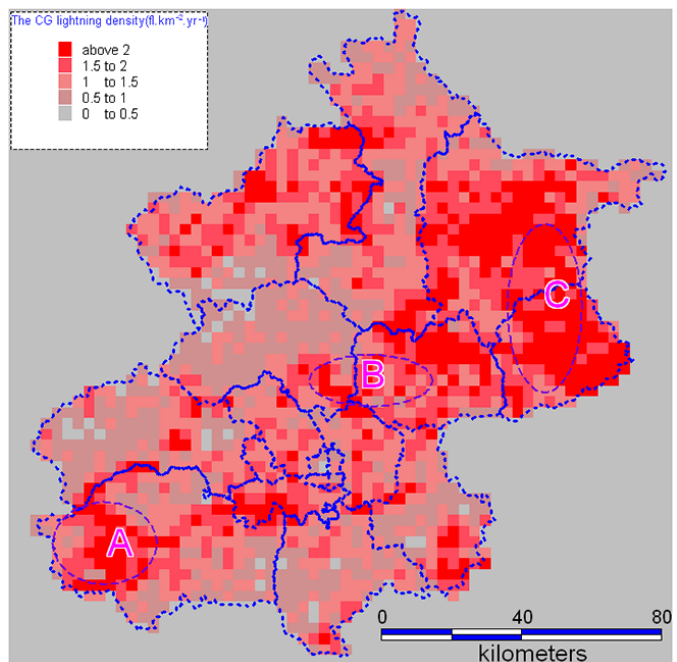
Figure 6. CG flash density distribution map derived from LLF data, highlighting the three high-density areas (A–C) in Beijing.